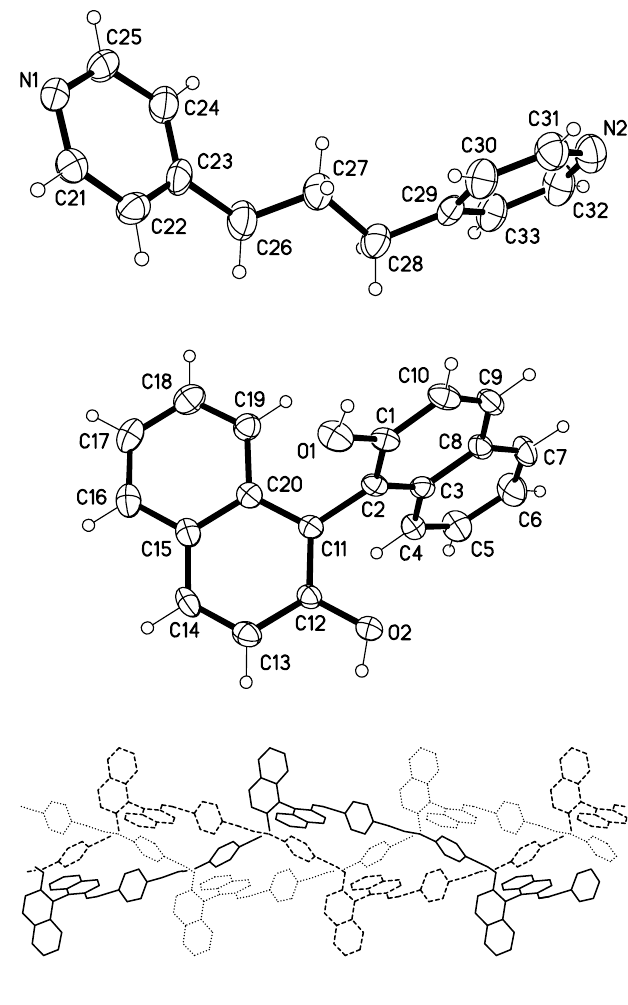
Table 1. D a t a collection a nd h a